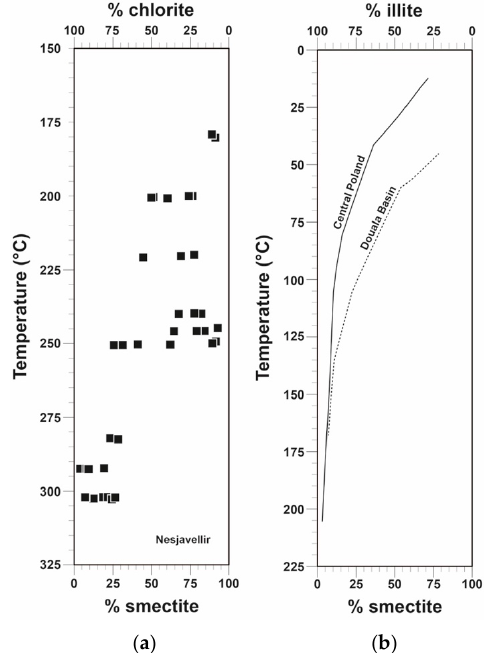
Figure 6. ( a ) Downhole temperature versus chlorite and smectite content, respectively, within interstratified chlorite / smectite minerals from well NJ-15 within the Nesjavellir geothermal system [5]. ( b ) Downhole temperature versus illite and smectite content, respectively, within interstratified illite / smectite minerals from sedimentary basin